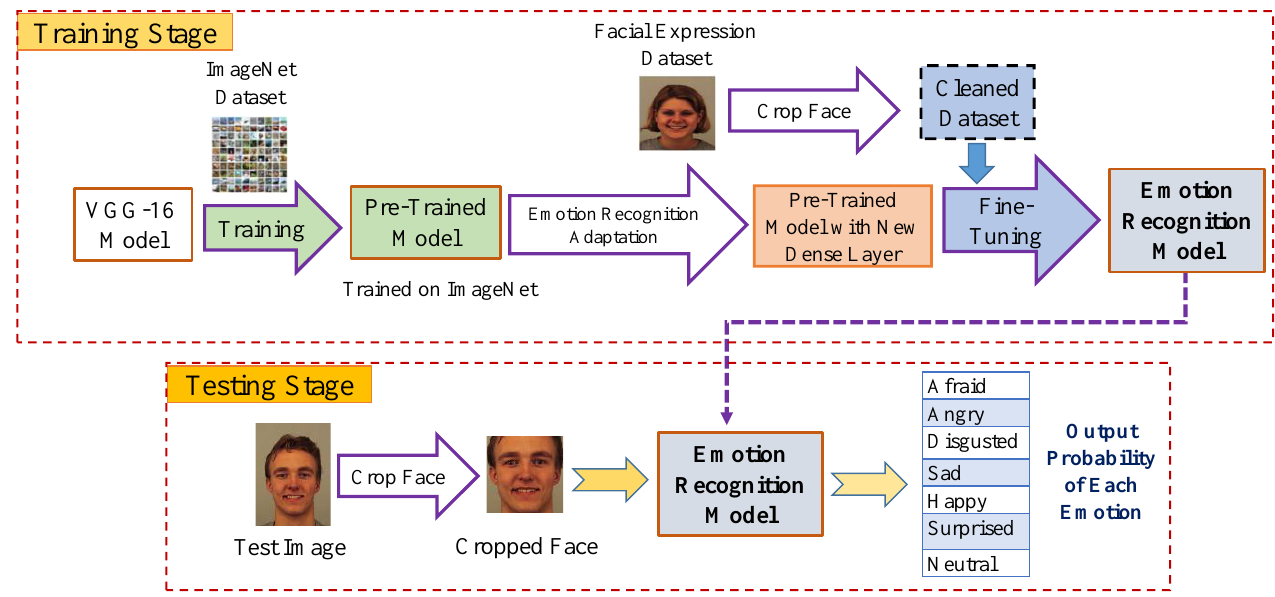
Figure 3. Illustration of the proposed FER system based on transfer learning in deep CNN.